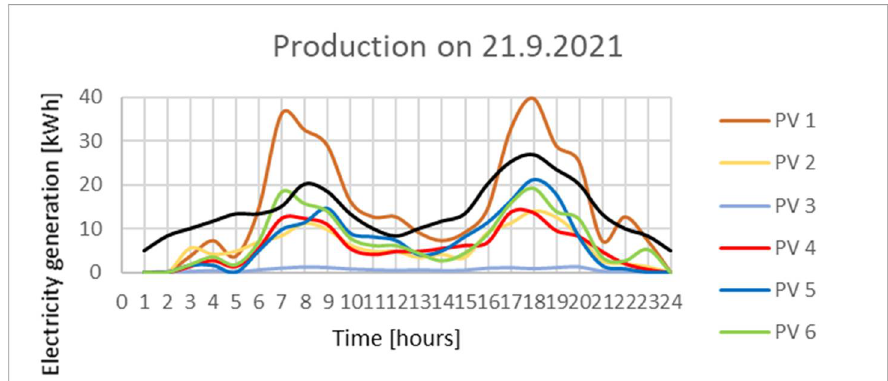
Figure 19. Energy flow from the photovoltaic power plant of Block A.